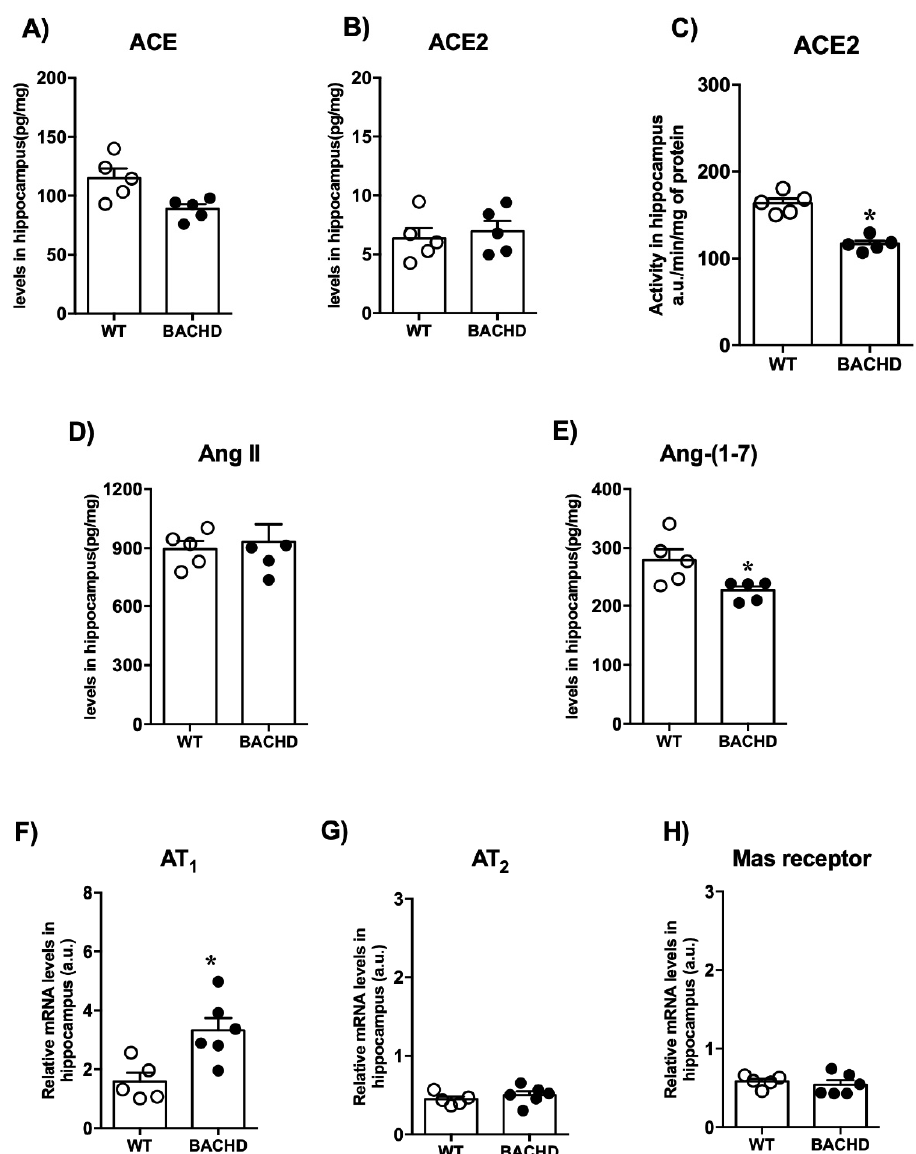
Figure 5. RAS components’ levels in the hippocampus of BACHD and WT mice. ( A ) ACE, ( B ) ACE2 levels, ( C ) ACE2 activity, ( D ) Ang II levels, ( E ) Ang-(1-7) levels, ( F ) AT 1 receptor expression, ( G ) AT 2 receptor expression, and ( H ) Mas receptor expression in the hippocampus of BACHD mice. Results are expressed as mean ± SEM. n = 5–6. * p < 0.05 compared with WT group. The data were analyzed by Student’s t -test.